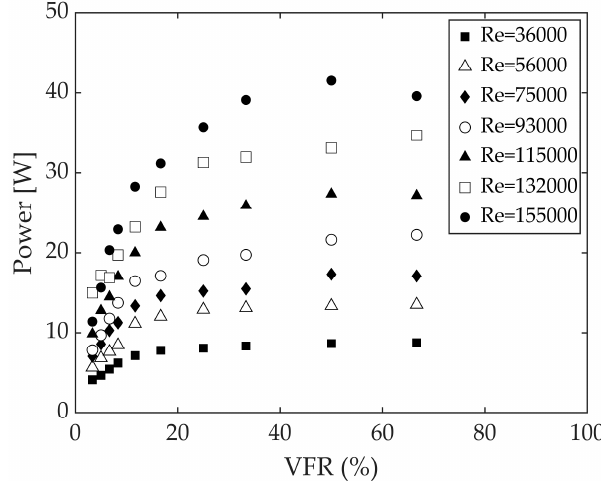
Figure 8. The power production for experimental CAV volume based on integrated pressure values.